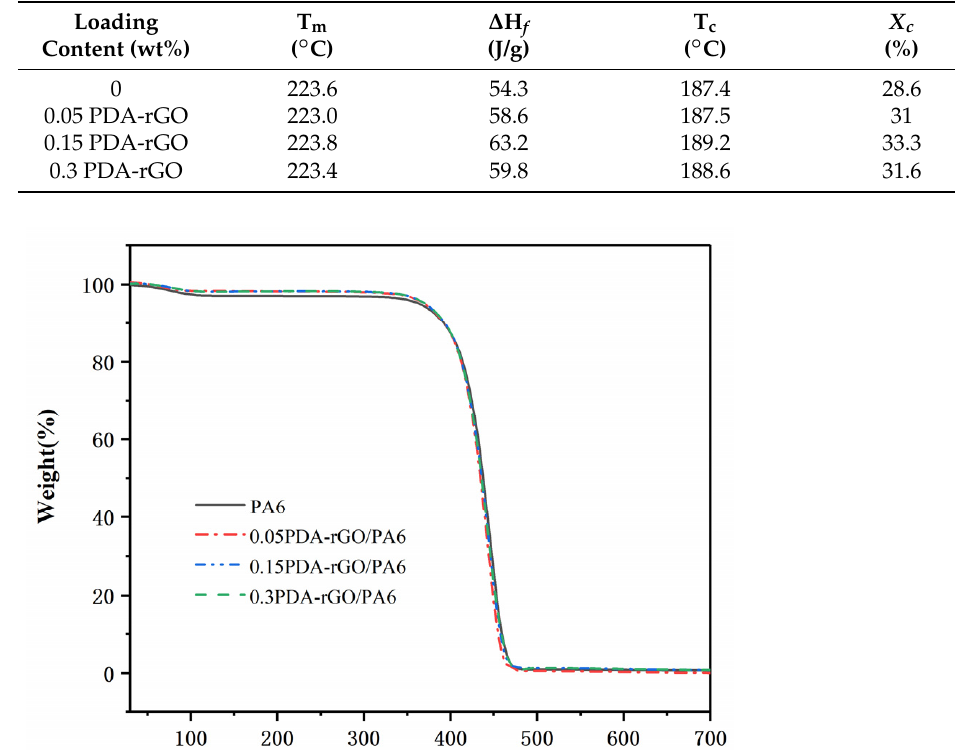
Figure 10. DSC plots of PDA-rGO/PA6 composite fibers with various PDA-rGO content: ( a ) melting curves; ( b ) crystallization curves. Table 2. DSC data of PA6 fiber and composite fibers containing different PDA-rGO content.